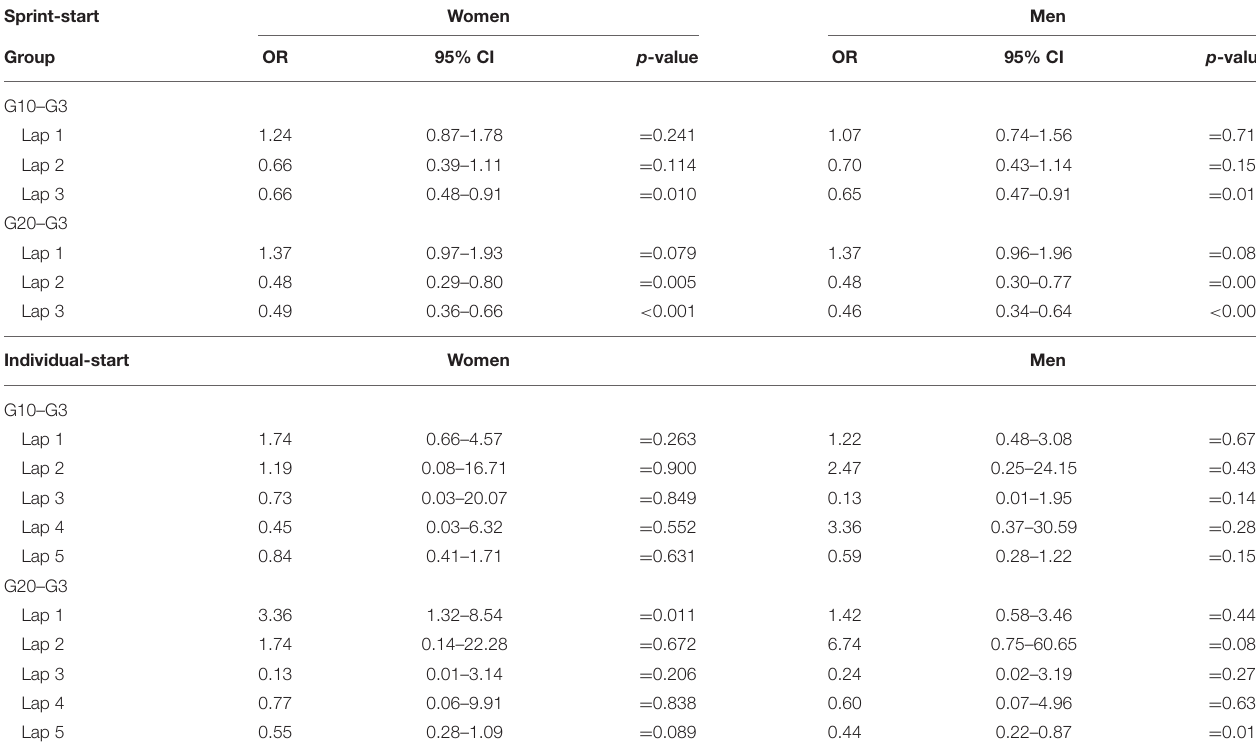
TABLE 1 | Multi-nominal logistic regression for skiing speed in women’s and men’s sprint and individual competitions in IBU WC 2002/2003–2018/2019.